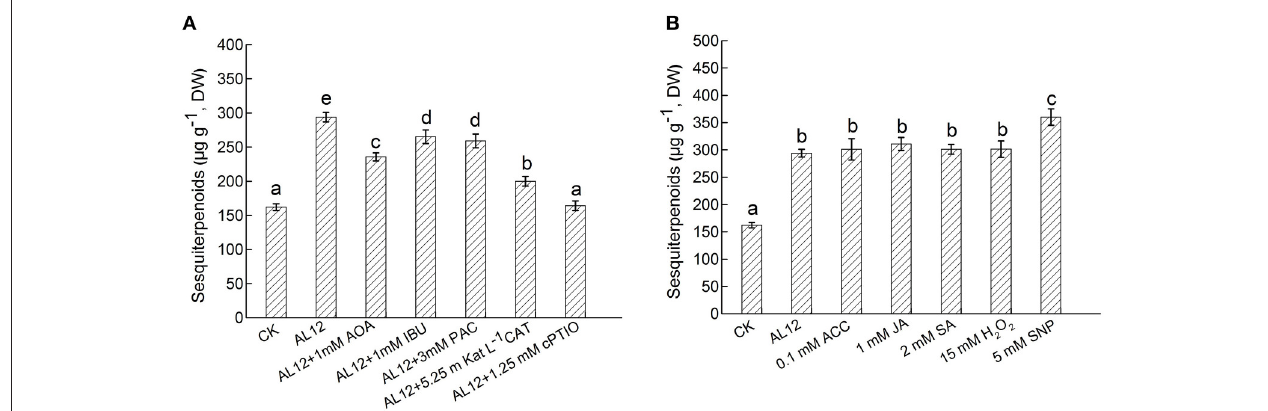
FIGURE 6 | (A) Contributions of five signals in endophytic fungus AL12-induced sesquiterpenoids accumulation in Atractylodes lancea plantlets. Thirty-day-old plantlets treated with 5-mm AL12 mycelial disks, 1 mM AOA, 1 mM IBU, 3 mM PAC, 5.25 m Kat L − 1 CAT and 1.25 mM cPTIO were harvested after 15 days to determine the sesquiterpenoids content. Inhibitors were added 1 day prior to endophytic fungus AL12 inoculation. Controls were established using equal sized potato dextrose agar disks. Values are the means of three independent experiments ± SD. Bars with different lowercase letters (e.g., a, b, c) are significantly different ( P < 0.05). (B) Comparison of five exogenous signal donor. Thirty-day-old plantlets treated with 5-mm AL12 mycelial disks, 0.1 mM ACC, 1 mM JA, 2 mM SA, 15 mM H 2 O 2 , and 5 mM SNP were harvested after 15 days to determine the sesquiterpenoids content. Controls were established using equal volume of double distilled water. Values are the means of three independent experiments ± SD. Bars with different lowercase letters (e.g., a, b, c) are significantly different ( P <